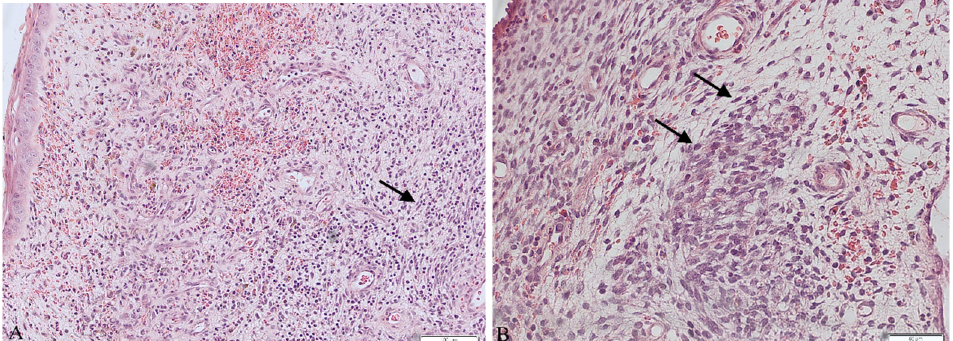
Figure 1. Histopathological images of the excised polyp ( A ) in 10× magnification. ( B ) in 20× magnification. Arrows show spindle and round pleomorphic cells with hyperchromatic nuclei and scant cytoplasm.